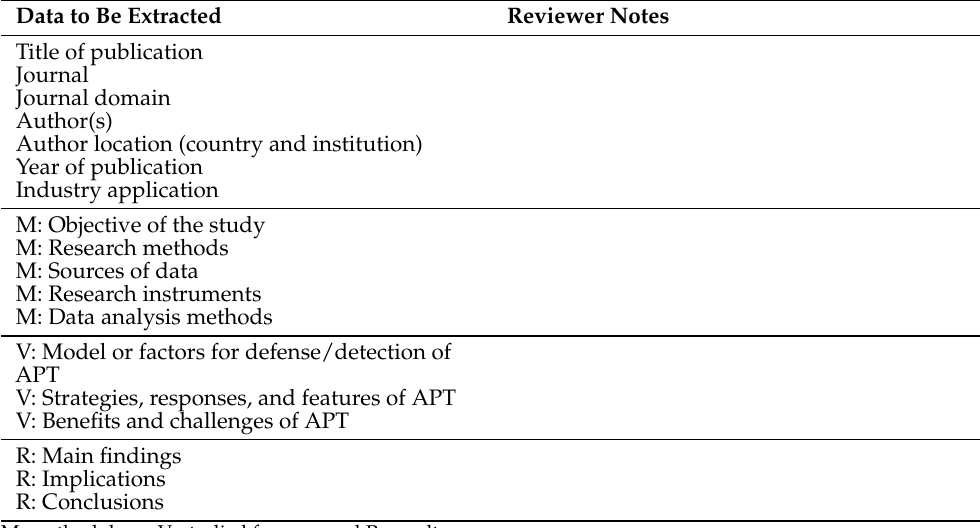
Table A1 is the extraction form used for extracting the information of the reviewed articles. Table A1. Extraction form used for the detection and defense of APT